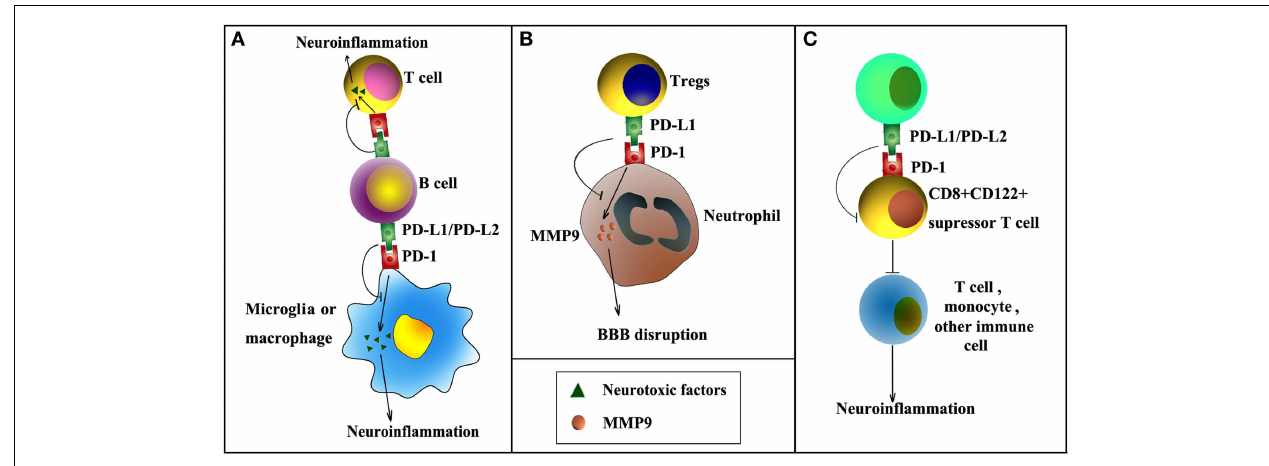
matrix metalloproteinase-9 (MMP-9) through PD-L1–PD-1 interactions and reduces subsequent blood–brain barrier (BBB) damage in the acute phase after stroke. (C) PD-L1/PD-L2 inhibits immunoregulatory CD8 + CD122 + suppressorT-cells, reducing their recruitment into the CNS from the spleen after stroke. As a result, post-stroke inflammation and brain injury are